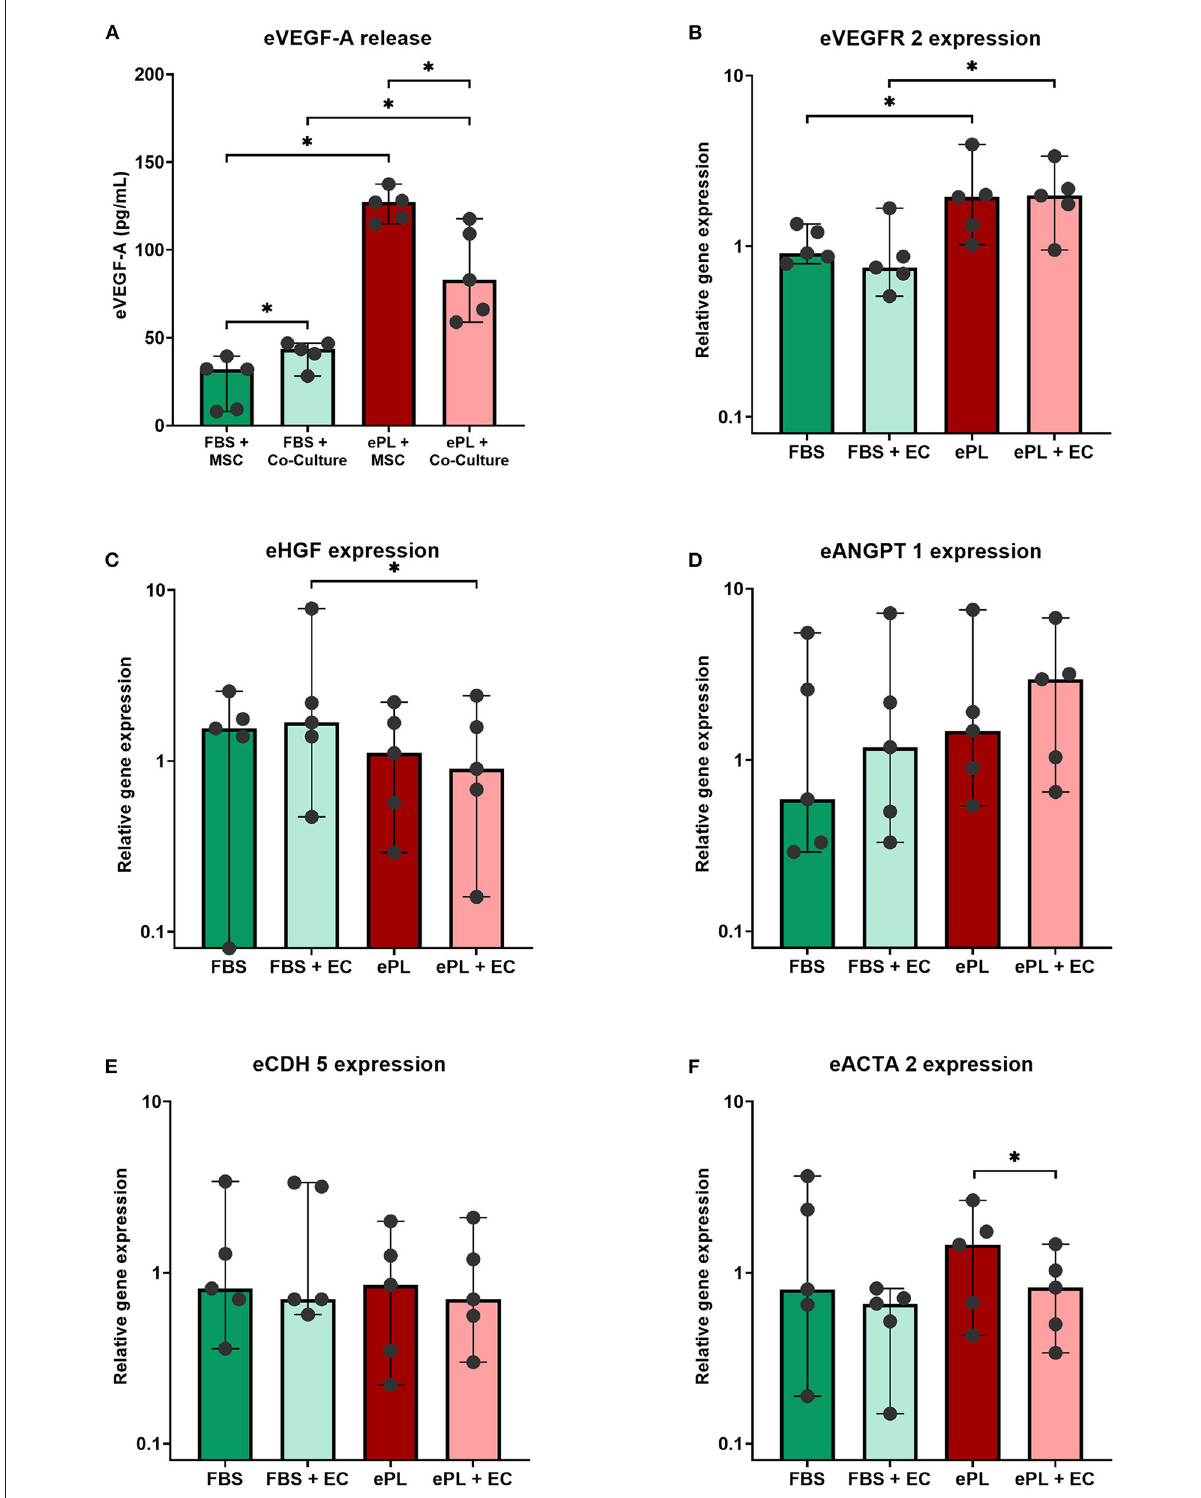
FIGURE3 Vascular endothelial growth factor (VEGF-A) (A) released into the supernatants and relative expression of angiogenesis-related genes in equine mesenchymal stromal cells (MSC) (B–F) , after MSC were cultured alone or in co-culture with endothelial cells (EC), either with 10% fetal bovine serum (FBS) and collagen matrix or 10% equine platelet lysate (ePL) and ePL matrix. Bars display the median values and error bars the 95% confidence intervals. Wilcoxon tests were performed to compare the corresponding groups. Asterisks mark significant differences between